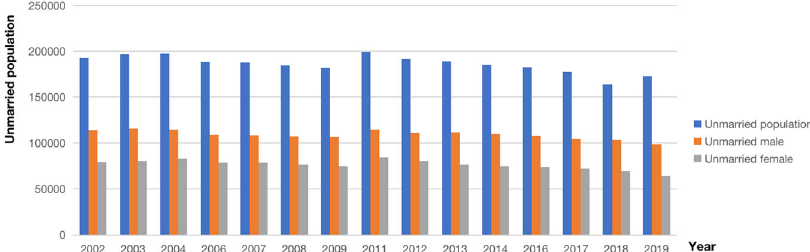
Fig. 3 Unmarried population in China by gender, 2002 – 2019. The bar chart in fi gure shows that the number of men is signi fi cantly larger than the number of women in the composition of the unmarried population.